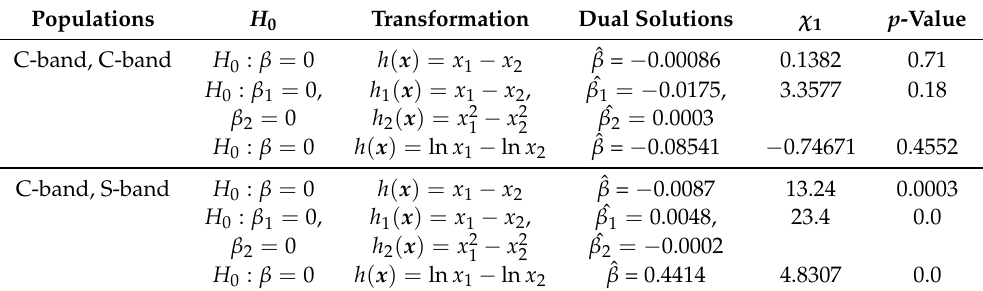
Table 4. Hypothesis testing when samples are coming from the same or different